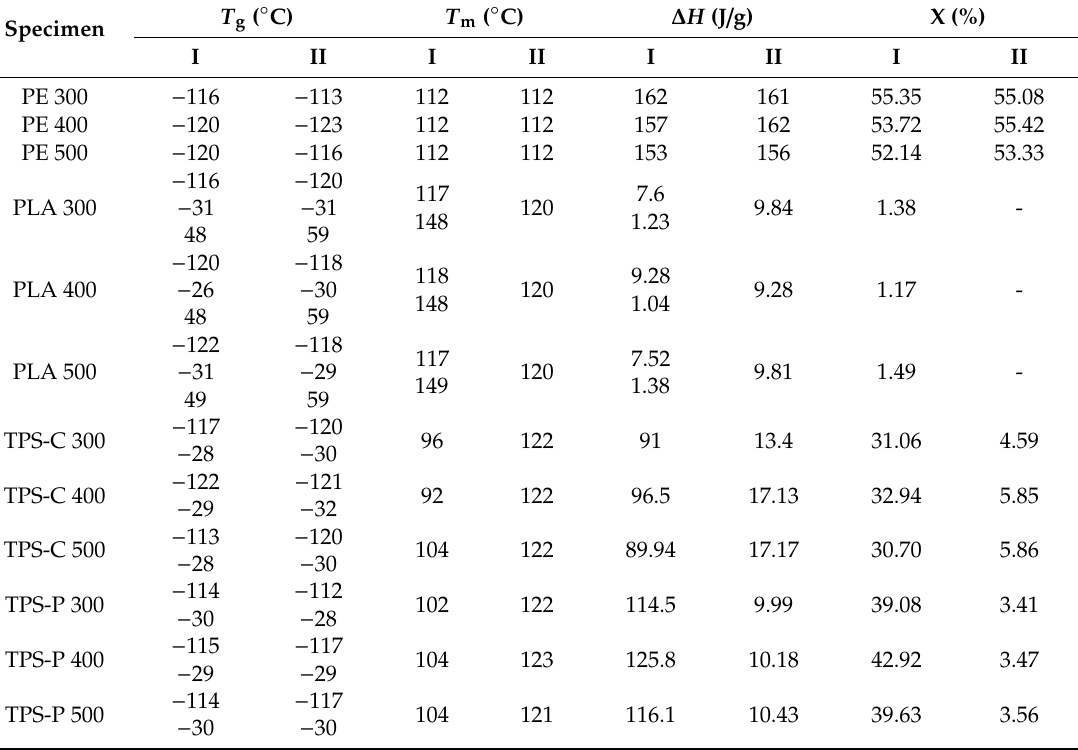
Table 3. DSC measurement results for films.